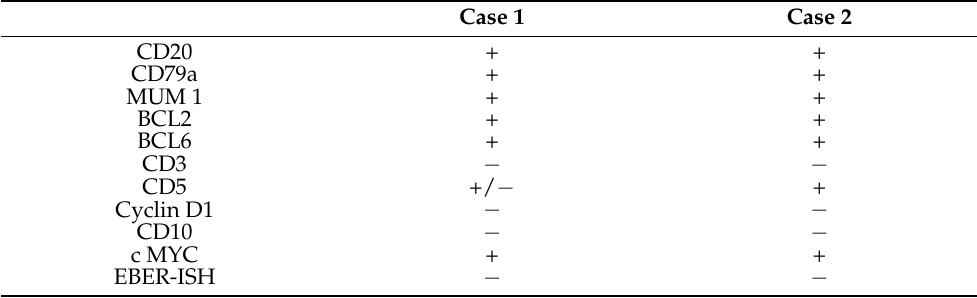
Table 2. Immunohistochemistry and ISH studies for the two cases of